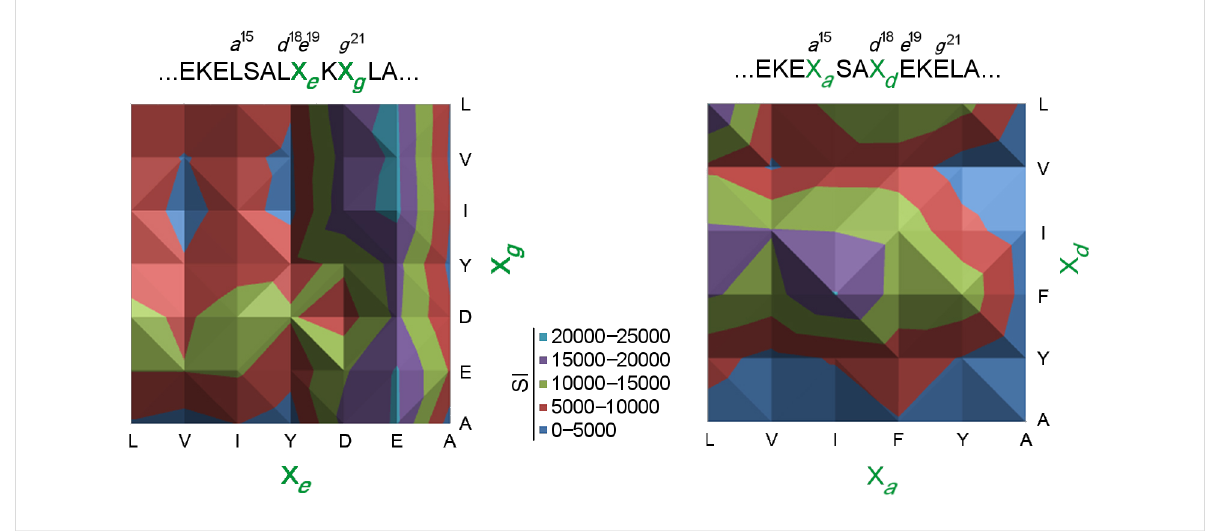
Figure 4: Heat-map diagrams depicting the quantitatively measured SIs for Acid-pp sequences containing mutations at positions e 19 and g 21 (left) and at positions a 15 and d 18 (right) in heptad III. The SIs corresponding to each color are displayed between the heat maps.